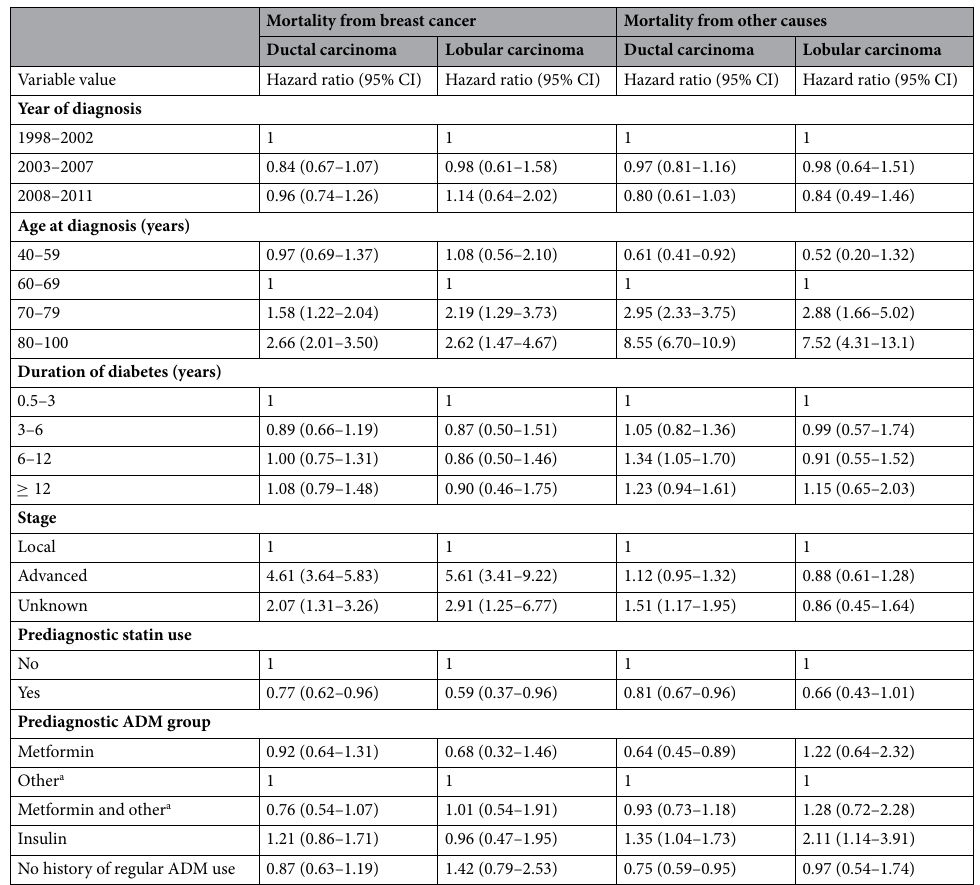
Table 2. Estimation results from Cox proportional hazard models of mortality from the two causes of death.